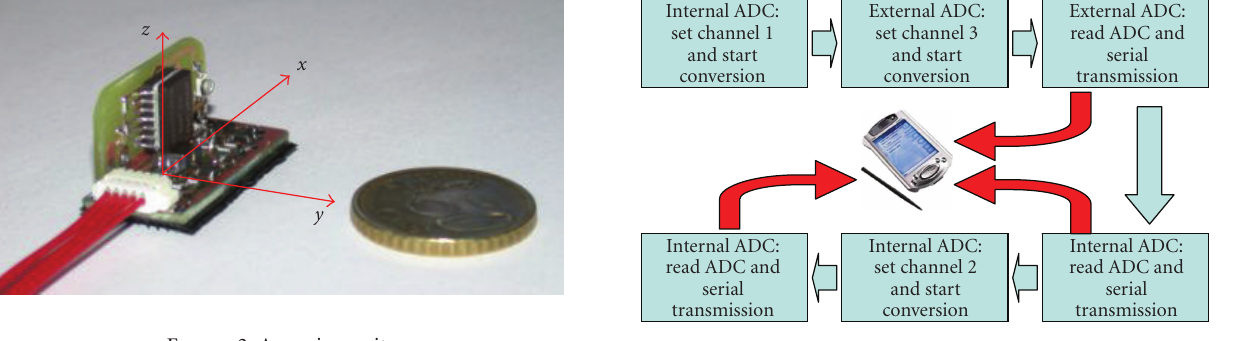
Figure 3: Acquisition